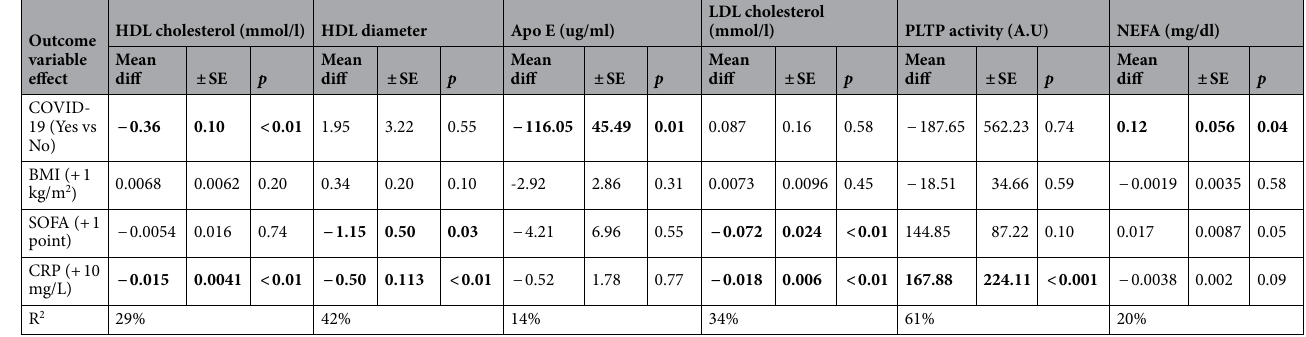
Table 3. Factors associated with lipid parameters in 61 patients with severe pneumonia (multivariate linear regression). SE standard error, BMI body mass index, SOFA sequential organ failure assessment, CRP C reactive protein, NEFA non-esterifierd fatty acid, LDL low density lipoprotein, HDL high density lipoprotein, PLTP phospholipid transfer protein, ApoE apolipoprotein E. Significant differences ( p < 0.05) are written in